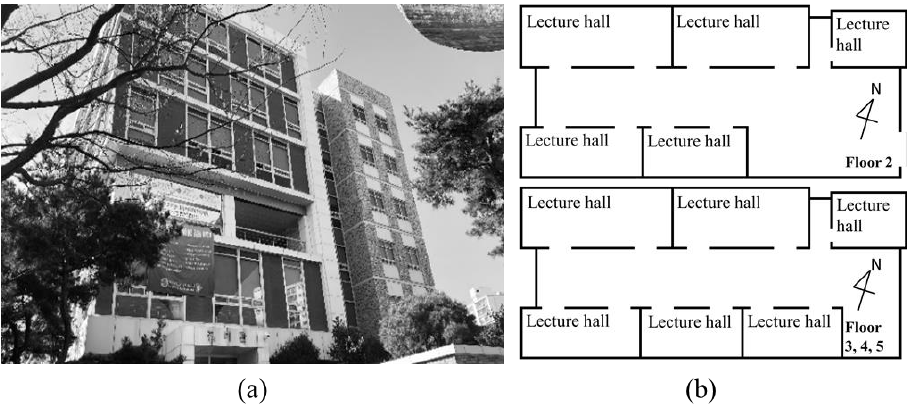
Figure 2. ( a ) Building used for demonstration, ( b ) layout of the building.